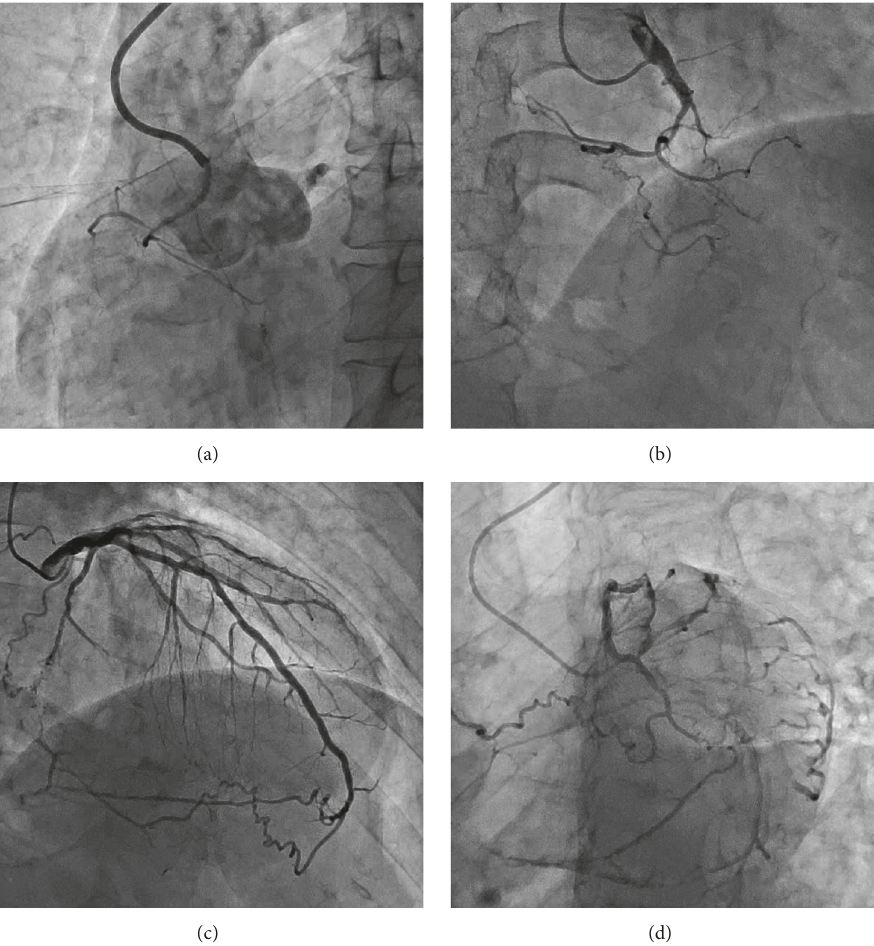
Figure 1: Profile of chronic total occlusion (CTO) of the patient. (a) CTO of the proximal right coronary artery (RCA) (right anterior oblique projection). Coronary angiography revealed an anomalous origin of RCA with high anterior take-off from the aorta. (b) CTO of the proximal RCA (left anterior oblique projection). Epicardial collateral channels via the apex from the left anterior descending artery to RCA [right anterior oblique projection (c) and spider projection